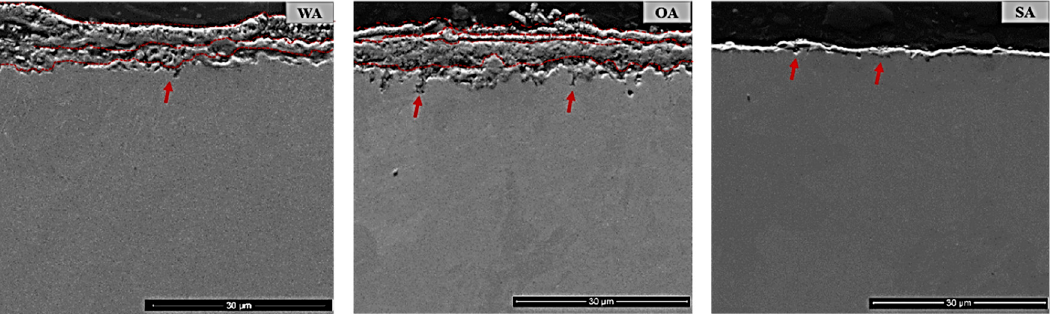
Figure 3. SEM images of cross-sections of Inconel 625 after exposure to the mixed wood biomass ash (WA), oat straw ash (OA), and sewage sludge ash (SA).